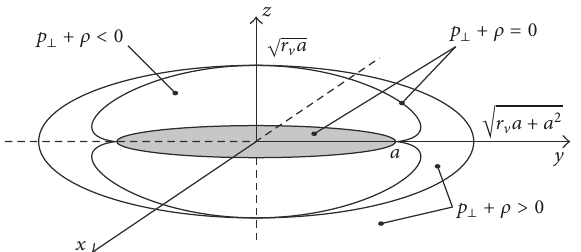
Figure 4: Second type of interior for regular rotating black holes and